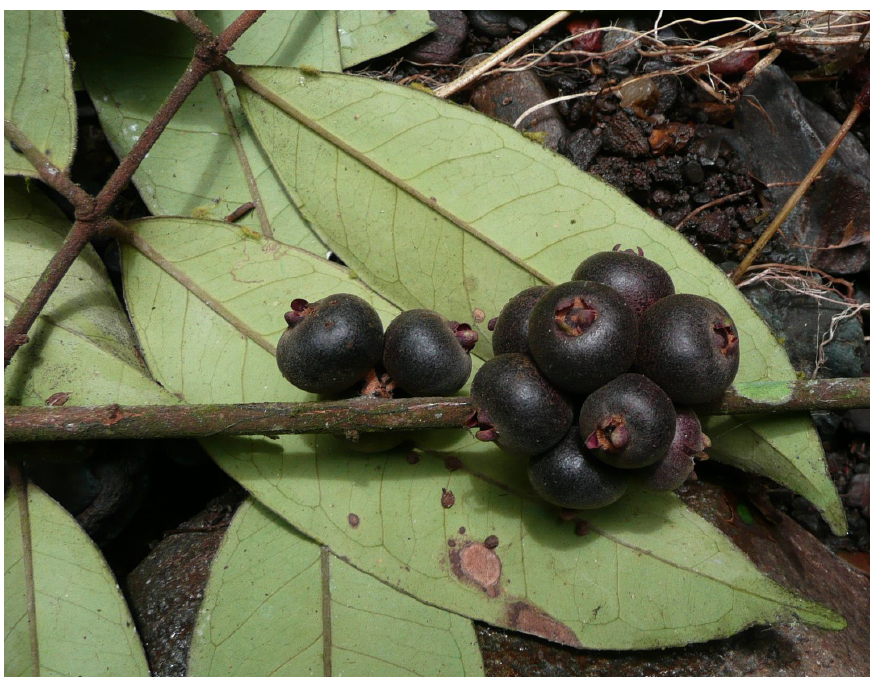
Fig. 1. Eugenia calophylloides DC. Branchlet with leaves and fruits. From Jongkind 8311 . Photographed by the